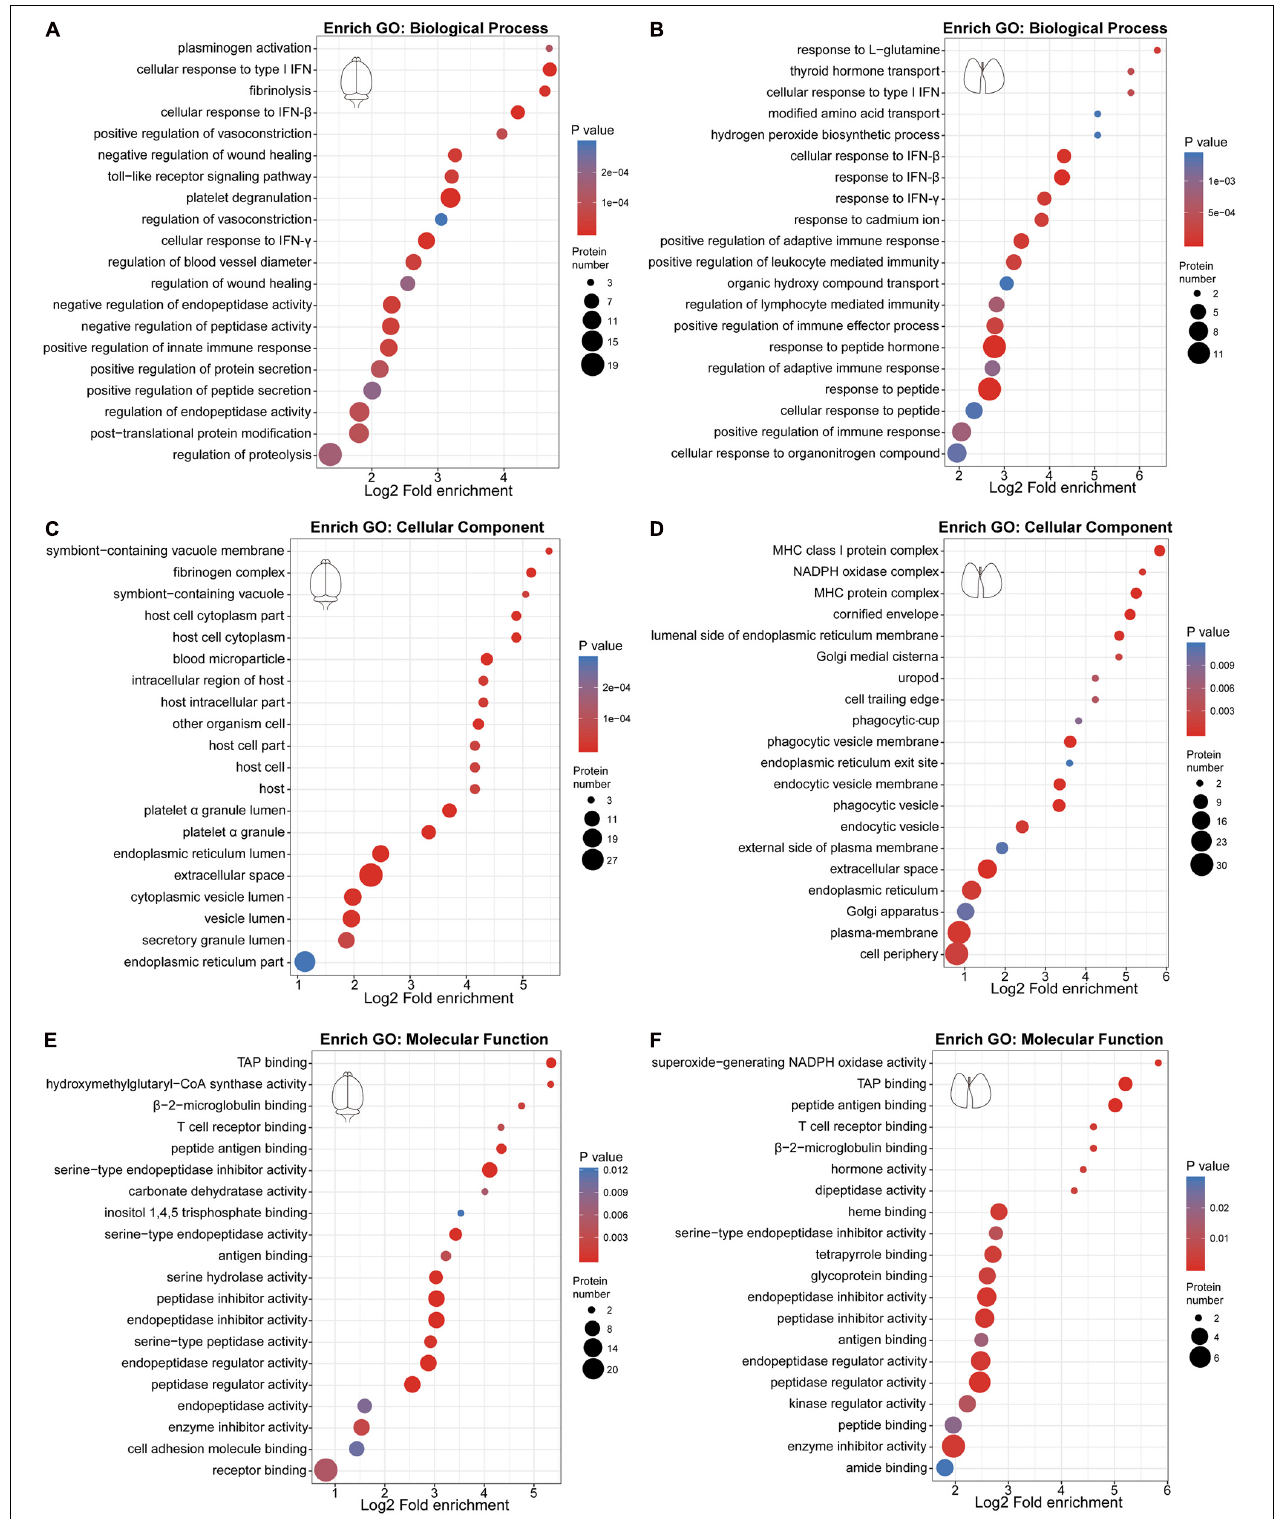
FIGURE 2 | Gene Ontology (GO) enrichment bubble plot of differentially expressed proteins in the three categories. (A,C,E) GO enrichment analysis of differentially expressed proteins in the brain. (B,D,F) GO enrichment analysis of differentially expressed proteins in the lung.